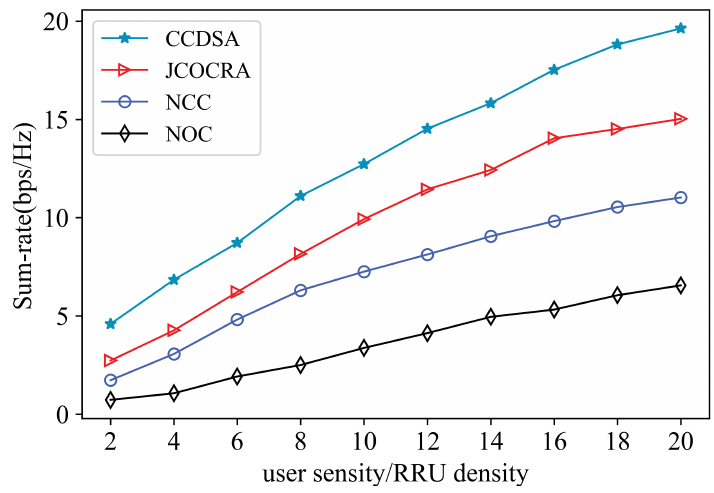
Figure 6. Sum-rate comparison of different scheme under different user density.